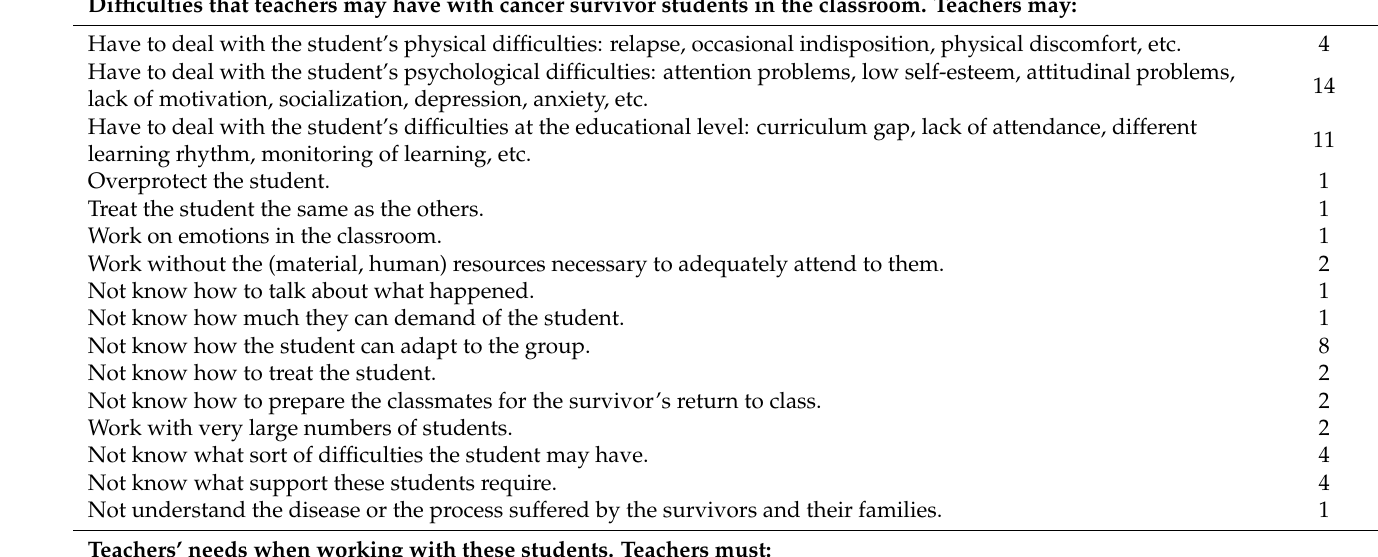
Table 2. Results from Round I (number of times items were